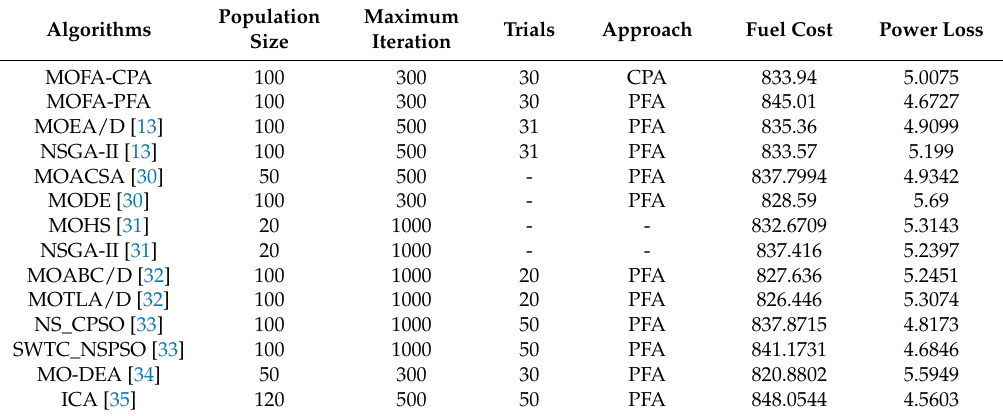
Table 6. Comparisons of the obtained BCS with other reported algorithms for Case